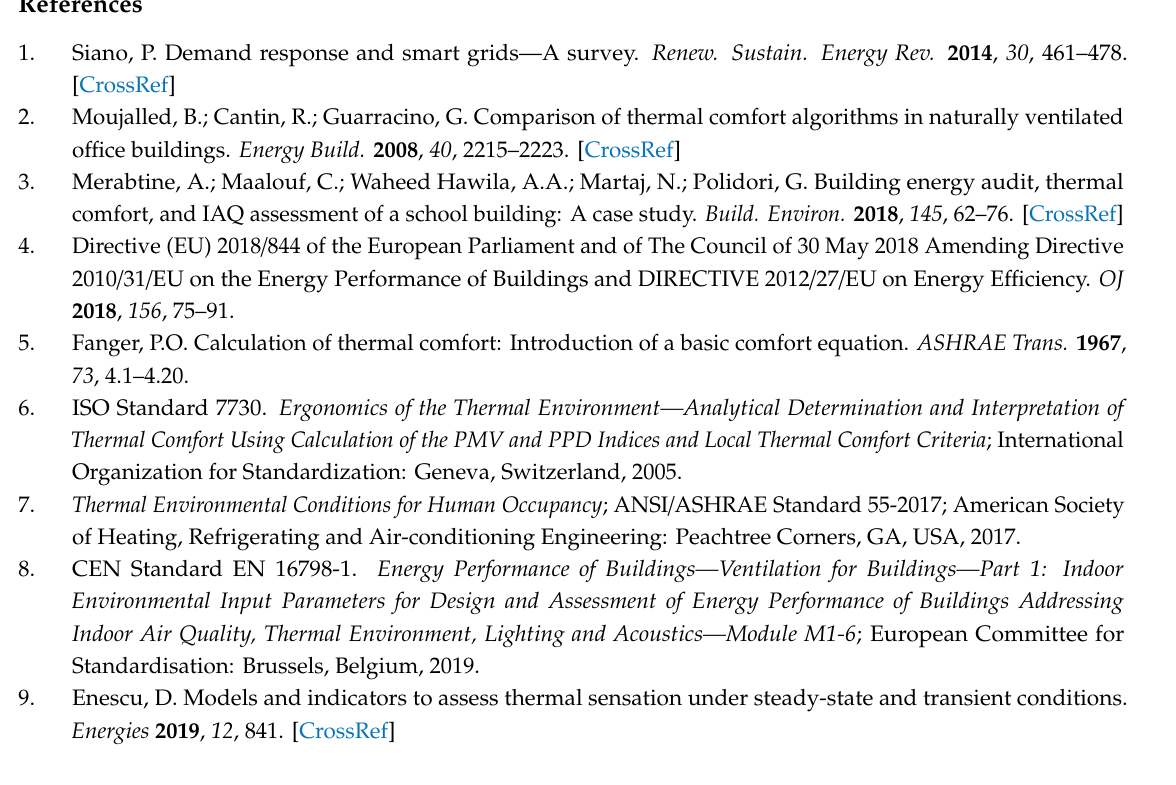
Table S1: Data on room occupancy during the study in 77 rooms, Table S2: Data on carbon dioxide concentration measurements in 77 rooms, Table S3: Data on thermal sensation, thermal acceptability, thermal preference and general sensation votes in 77 rooms according to 1369